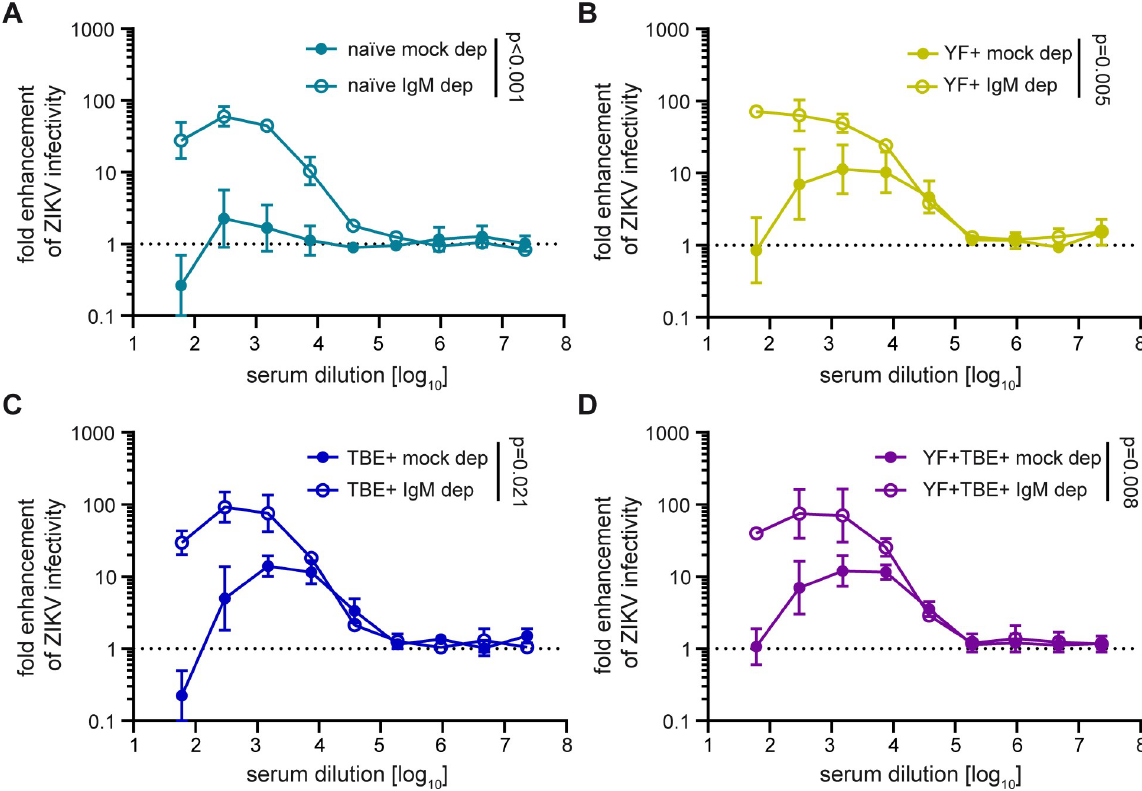
Fig 4. Effect of IgM depletion from serum pools on ADE of Zika virus infection. Serum pools were depleted with IgM agarose beads as described in Methods. Fc γ receptor-positive K562 cells were infected with Zika virus in the presence of serially diluted (A) flavivirus-na ï ve pool, (B) YF pre-vaccinated pool, (C) TBE pre-vaccinated pool, and (D) YF and TBE pre-vaccinated pool. Colored symbols: mock depletion, empty symbols: IgM depletion. Data are shown as mean values +/- range from two independent experiments. Dotted line indicates no enhancement of infection. Comparison of fold-enhancement of Zika virus infection in the presence of depleted and mock-depleted pools was performed by applying a GLM as described in Methods. p-values are indicated in the graphs. ZIKV, Zika virus; na ï ve, flavivirus na ï ve serum pool; YF+, yellow fever pre-vaccinated serum pool; TBE+, tick-borne encephalitis pre-vaccinated serum pool; YF+TBE+: yellow fever and tick-borne encephalitis pre-vaccinated serum pool; mock dep, mock-depleted serum pool; IgM dep, IgM-depleted serum pool.